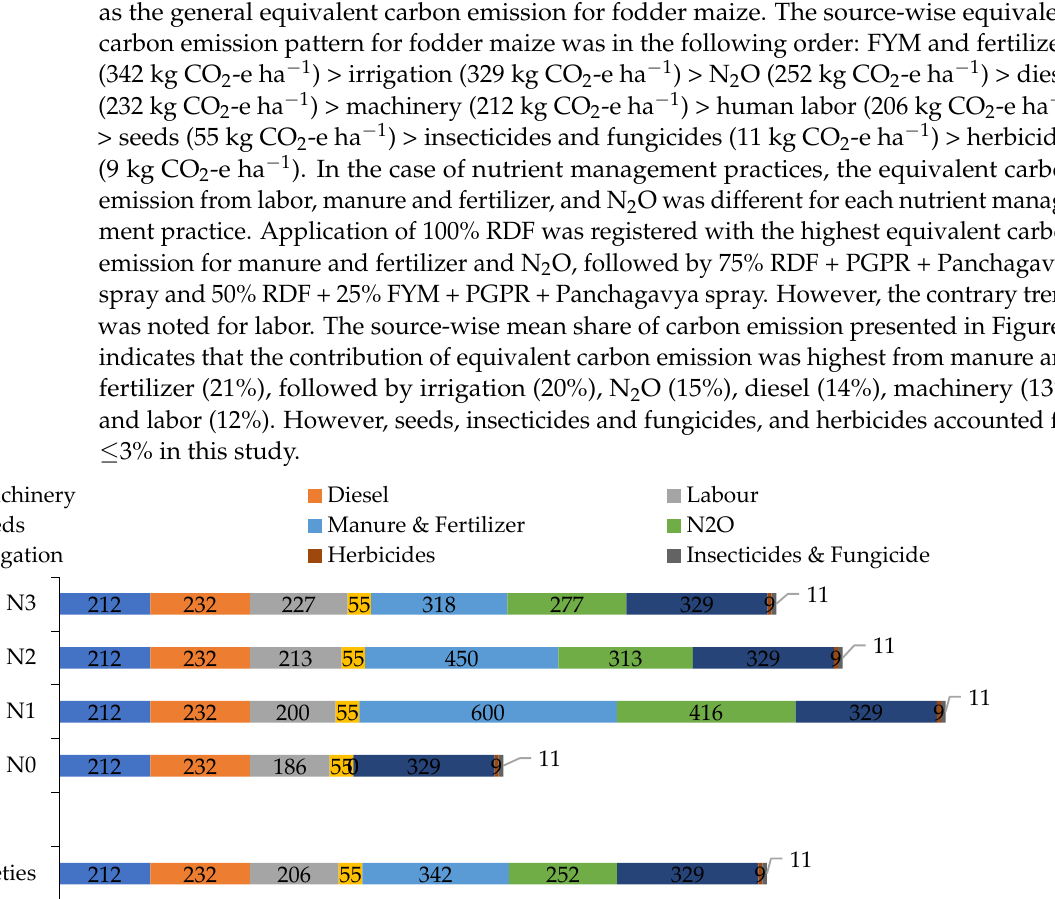
Figure 8. Source-wise mean share of carbon emission for the cultivation of fodder maize (mean of two years).